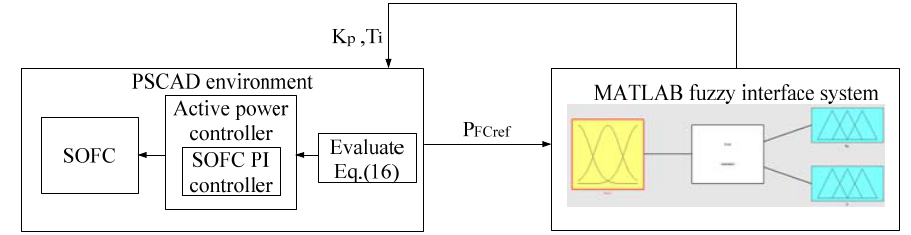
Figure 6. Block diagram for fuzzy ‐ based proportional and integral (PI) control.